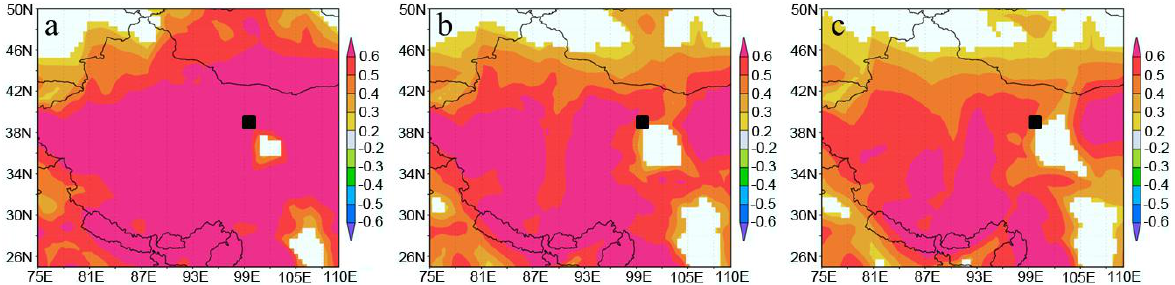
Figure 8. Correlations of the instrumental (a) and reconstructed (b) January–August T min with the CRU gridded January–August T min for western China during the period 1960–2012, as well as correlation of reconstructed T min with the CRU gridded January–August T mean for the same period (c) . The black square indicates the location of this study. Fig. 8 Correlations of the instrumental (a) and reconstructed (b) January-August Tmin with 9 the CRU gridded January-August Tmin for western China during the period 1960-2012, as well as 10 correlation of reconstructed Tmin with the CRU gridded January-August Tmean for the same 11 period(c). The black square indicates the location of this study. 12